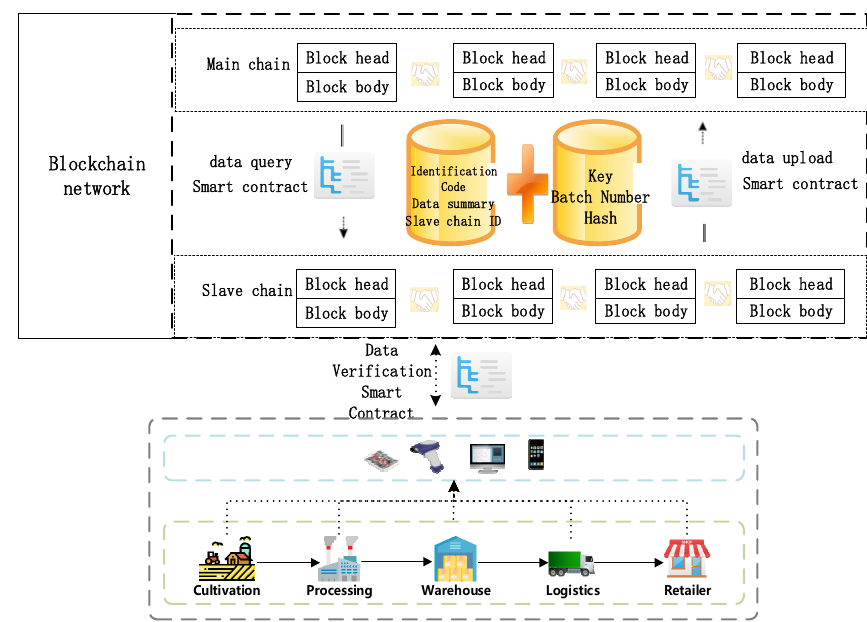
Figure 5. Data storage mechanism based on blockchain master–slave multi-chain.